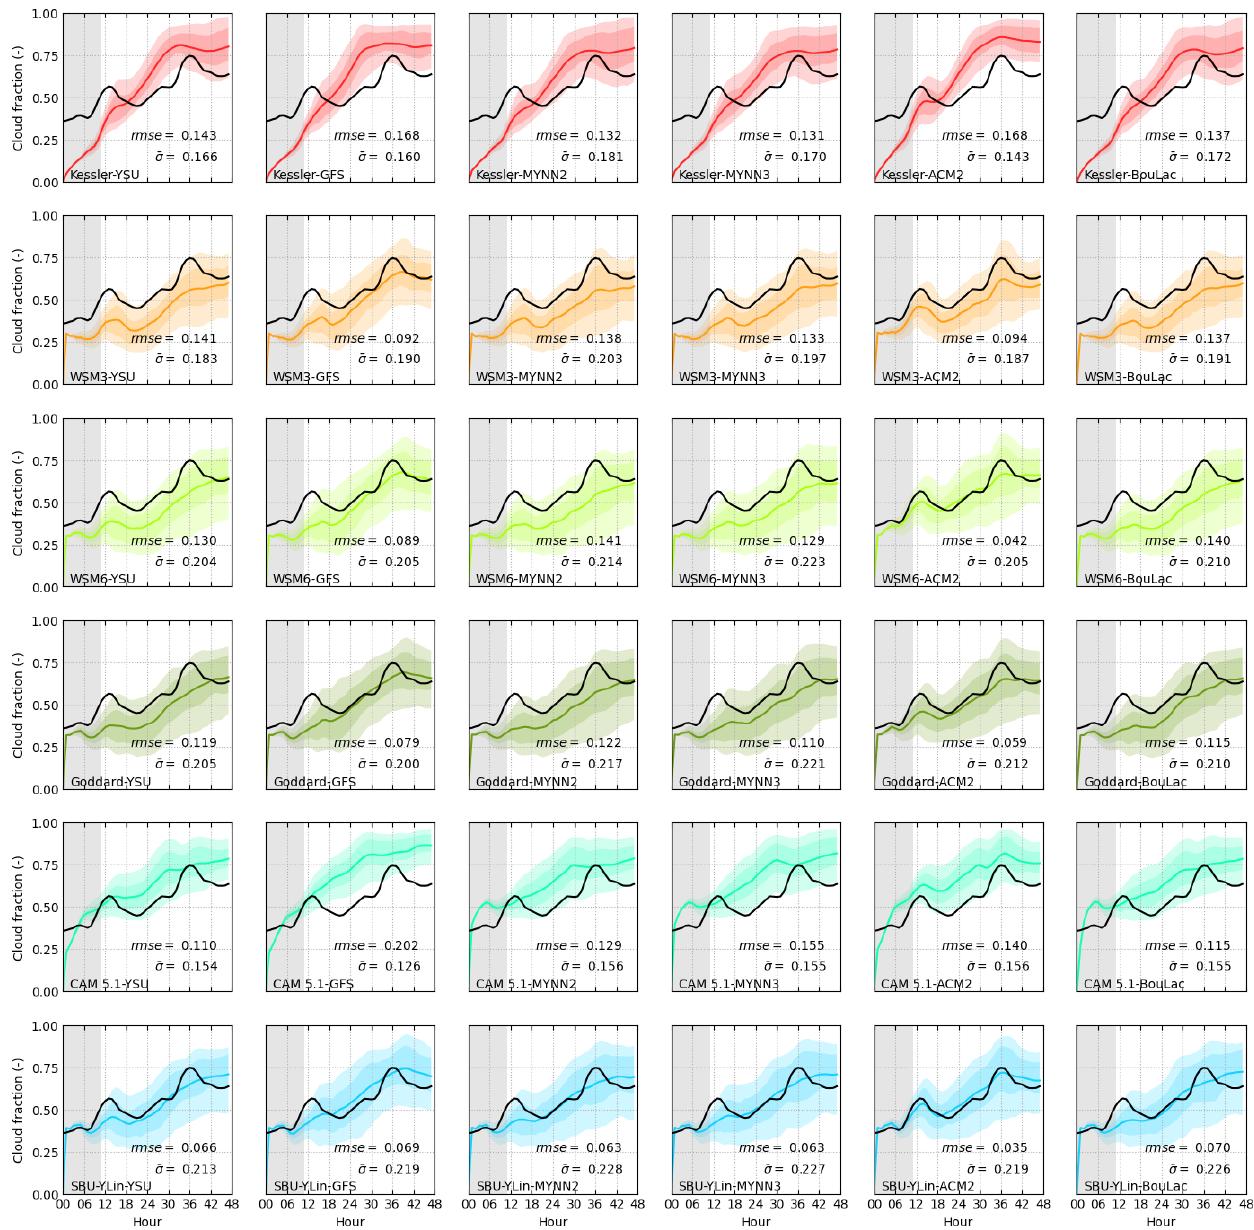
Figure 15. The mean cloud cover fraction (–) and the observation from the satellite (black line) and by simulation (color line) from the combination of microphysics (by different colors) and PBL physics (in different rows) for the case on 23 August. The color block represents the range of percentiles, the darker block is limited between 25% and 75%, and the lighter block is limited between 5% and 95%. The gray block indicates the spin-up time for ESIAS-met, which is not included in the root mean square error (rmse), standard deviation ( ¯ σ ), or the mean simulated cloud cover fraction ( ¯ x